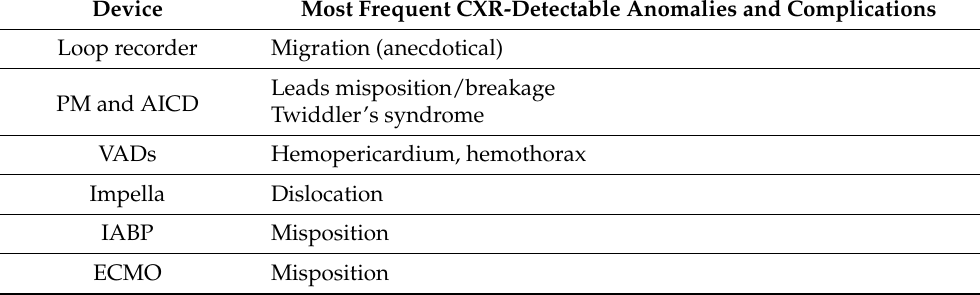
Table 4. Cardiac devices’ most frequent CXR-detectable anomalies and